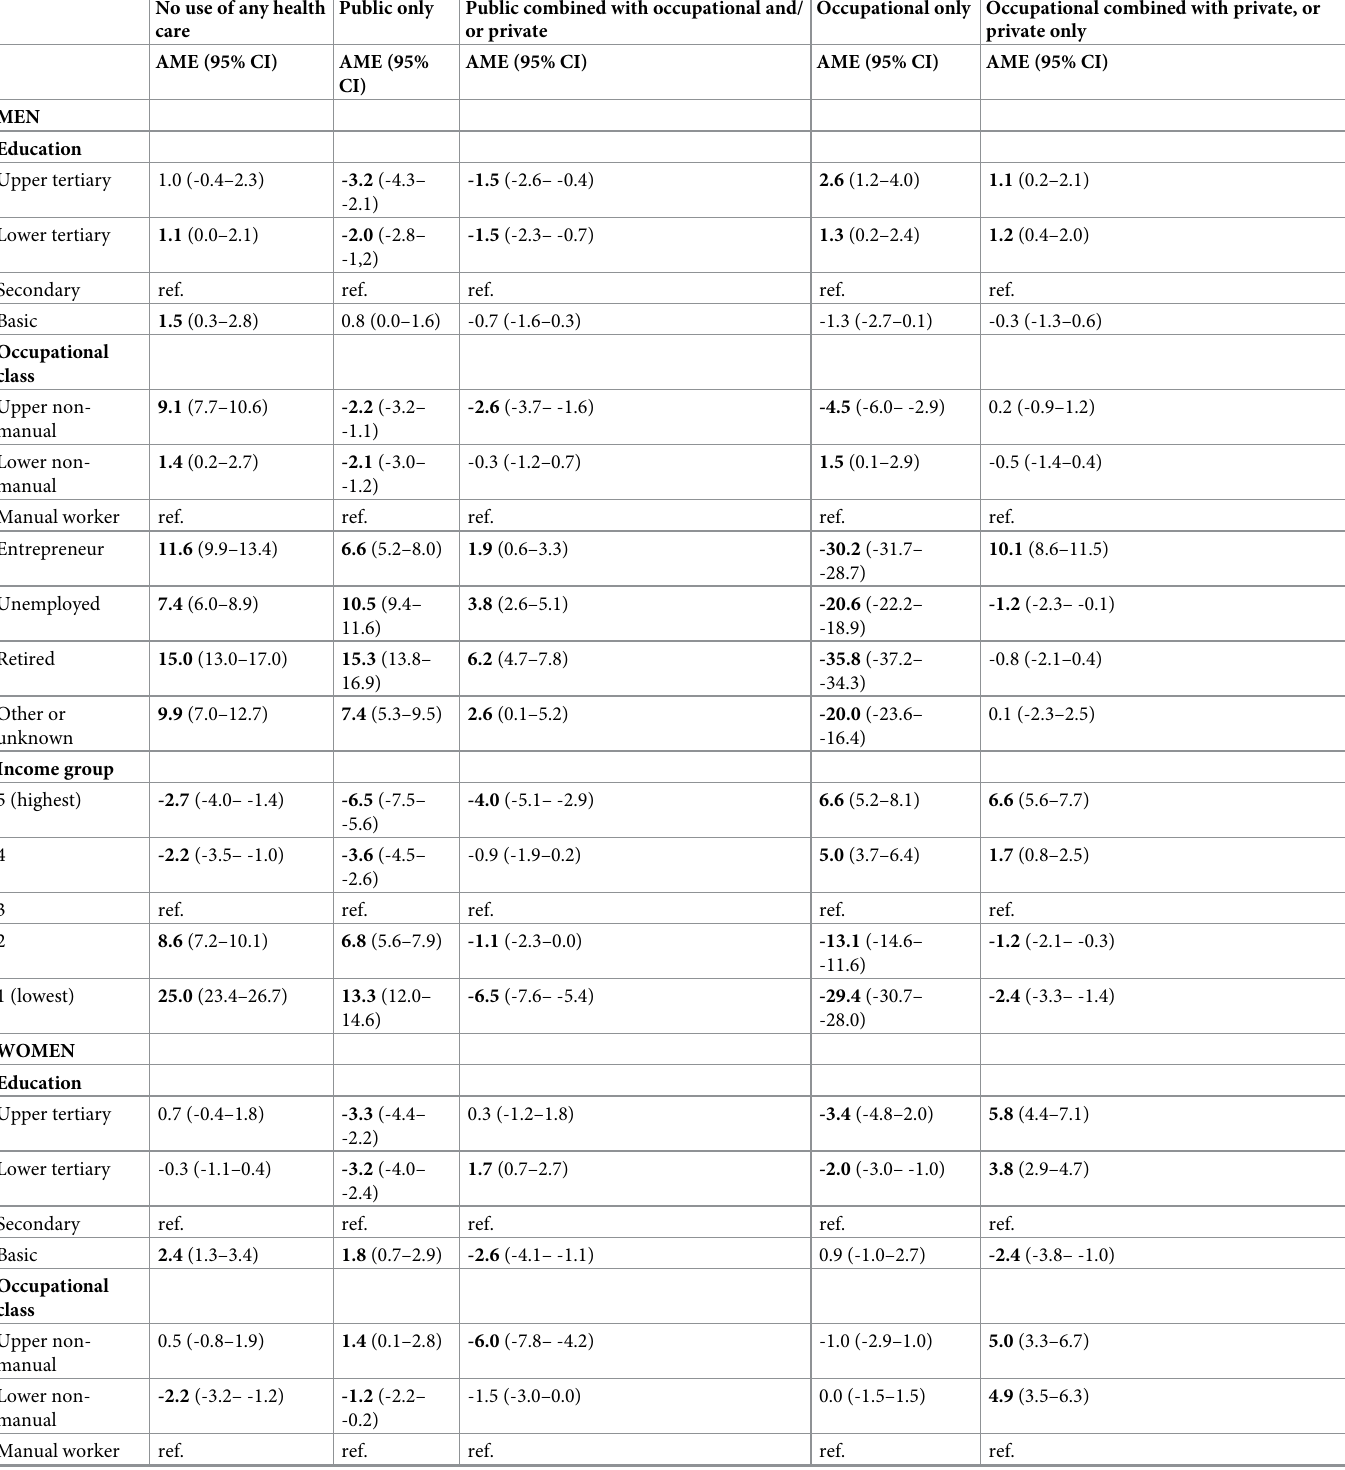
Table 2. Adjusted average marginal effects (AME) a for being in each of the user categories of outpatient primary health care schemes during year 2013 according to socioeconomic